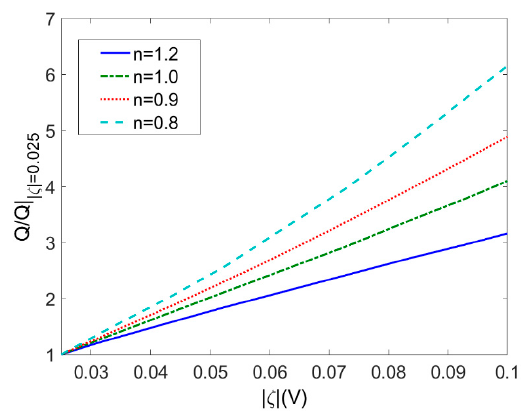
Figure 8. Variation of the total flow rates generalized by the total flow rate when ζ = − 0.025 V with zeta potential ζ at different flow behavior indices n ( c = 0.01 mol/m 3 , V = 10 V, L = 20 μ m, φ =